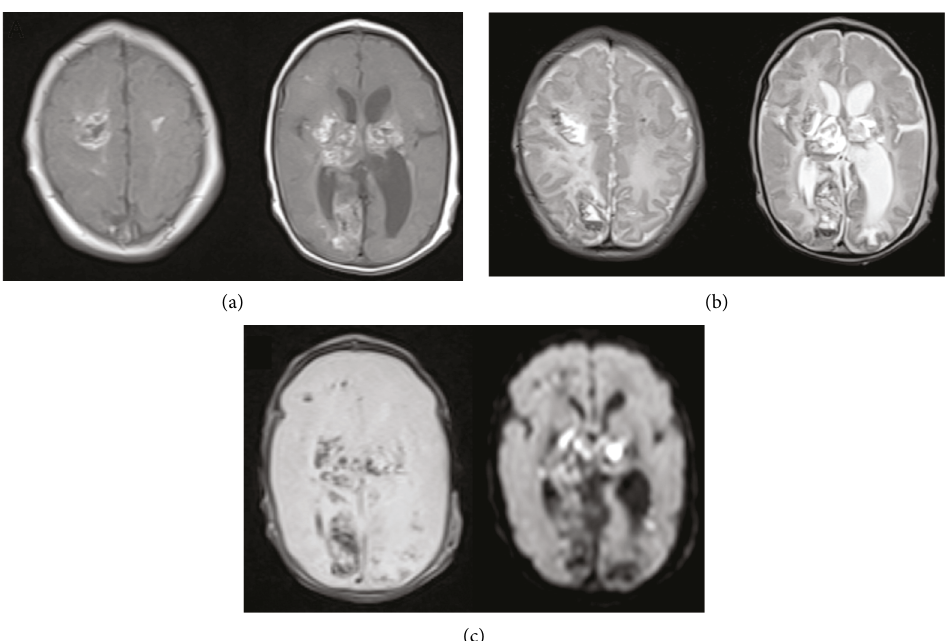
Figure 2: Brain MRI, multiple hemorrhagic infarcts with intraventricular perforation. (a): T1-weighted images, (b): T2-weighted images, and (c): T2 ∗ and DWI